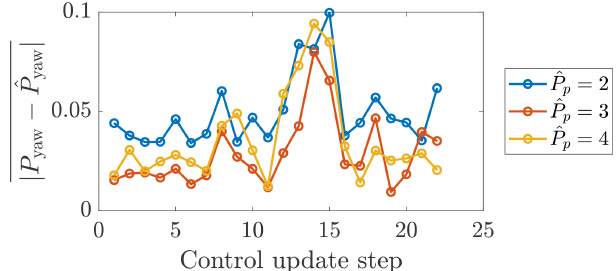
Figure 22. The mean absolute errors for the lifting line model pre- dictions as a function of the control update step for the convention- ally neutral ABL with ˆ P p = 2, 3, and